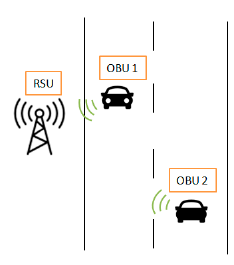
Figure 1. System components .